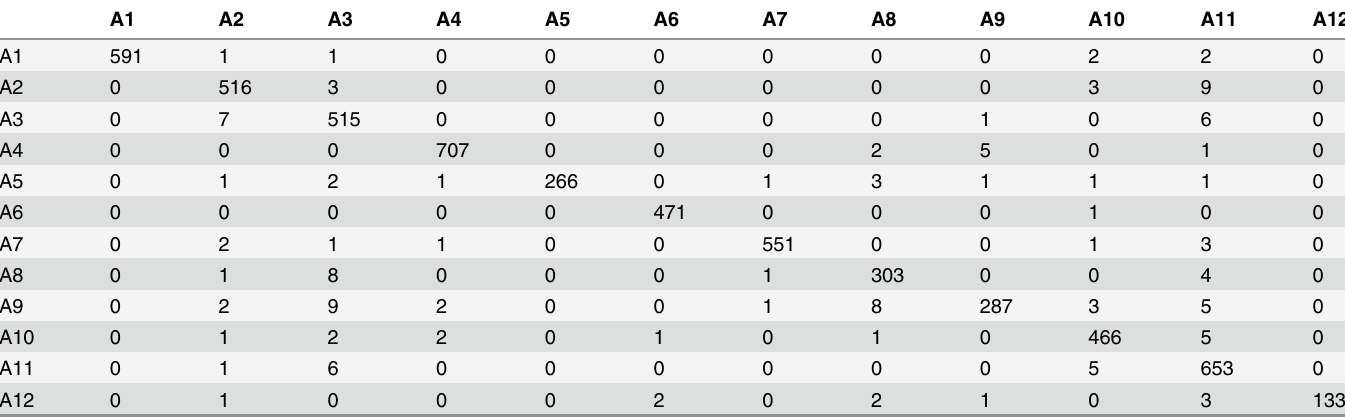
Table 9. Confusion matrix for rotation forest classifier (All Acceleration sensors).